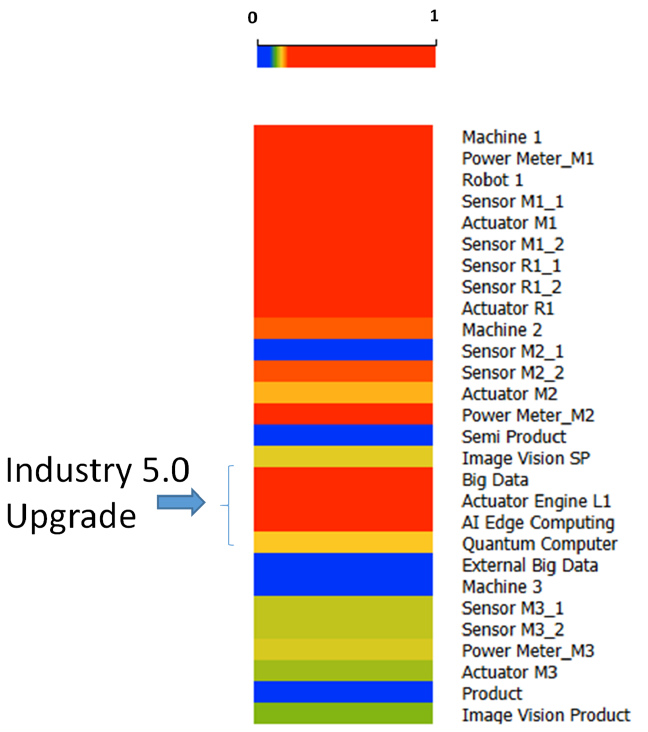
Figure 5. Heat map: diffusion heat simulation of the complex Industry 5.0 model enhancing central elements of the industry upgrade ( Big Data, Actuator Engine L1, AI Edge Computing, Quantum Computer ).